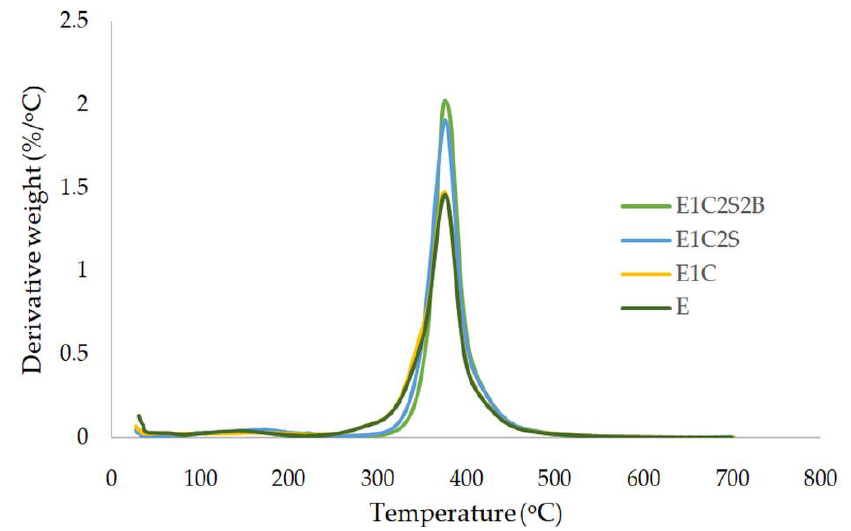
Figure 4. Dynamic TG profiles of composites.